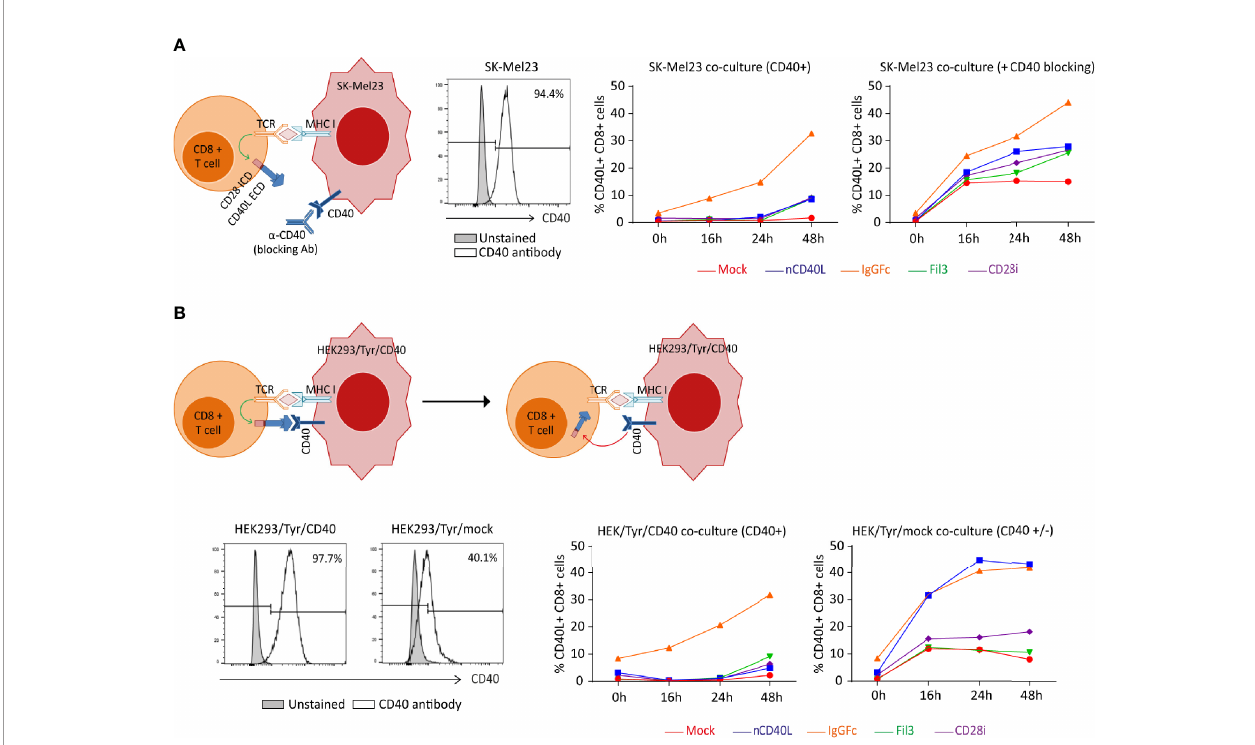
FIGURE 6 | CD40L:CD28 CSP expression kinetic on T cells after recognition of peptide/MHC ligands on target cells in the presence or absence of target cell- expressed CD40 receptor. Human TCR-T58 T cells (tyrosinase-speci fi c, HLA-A2 restricted) expressing the CD40L:CD28 CSPs were frozen on day 12 after CSP transduction. After thawing, T cells were used in co-cultures at a T cell to target cell ratio of 1:10. CSP surface expression on TCR-T58 T cells was analyzed by fl ow cytometry and is expressed as percentage of gated single, live, CD8+ CD40L+ cells. Mock-transduced TCR-T58 T cells (red line) and TCR-T58 T cells transduced to express the native CD40L (blue line) were used as reference. TCR-T58 T cells transduced with CD40L:IgGFc:CD28 are depicted in orange, those with CD40L:Fil3: CD28 CSP are depicted in green and T cells with CD40L:CD28i CSP are depicted in purple. (A) Target cells were SK-Mel23 cells or SK-Mel23 that had been pre- treated with anti-CD40 antibody in a 1:11 concentration (clone HB14 pure functional grade, Miltenyi) before setting the co-culture to block the endogenous CD40 receptor. Histograms of CD40 expression on SK-Mel23 cells, line histogram depicts the speci fi c staining for CD40 and the grey fi lled histogram is the unstained control. (B) Target cells were HEK293/Tyr/mock cells that had very low endogenous CD40 expression or were transduced to strongly express CD40 (HEK293/Tyr/ CD40). Line histogram depicts the speci fi c staining for CD40 and the grey fi lled histogram is the unstained control. This is one representative experiment of